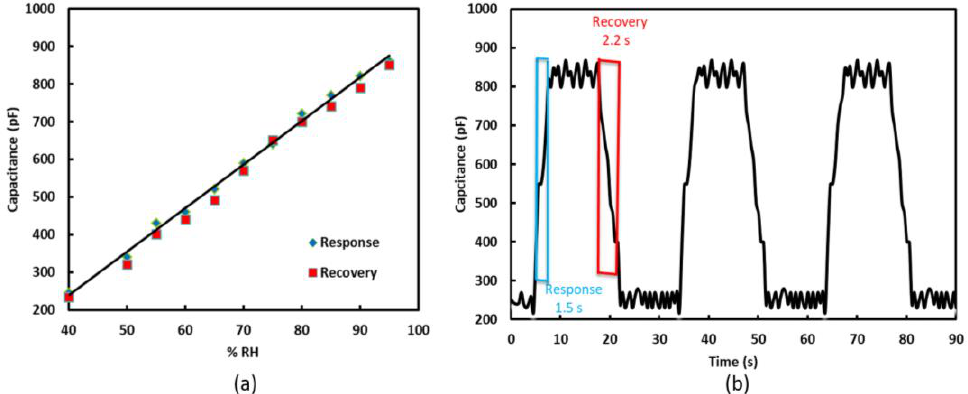
Figure 6. Response and recovery of sensor: ( a ) Relation between capacitance and RH; ( b ) Transient response of the sensor.